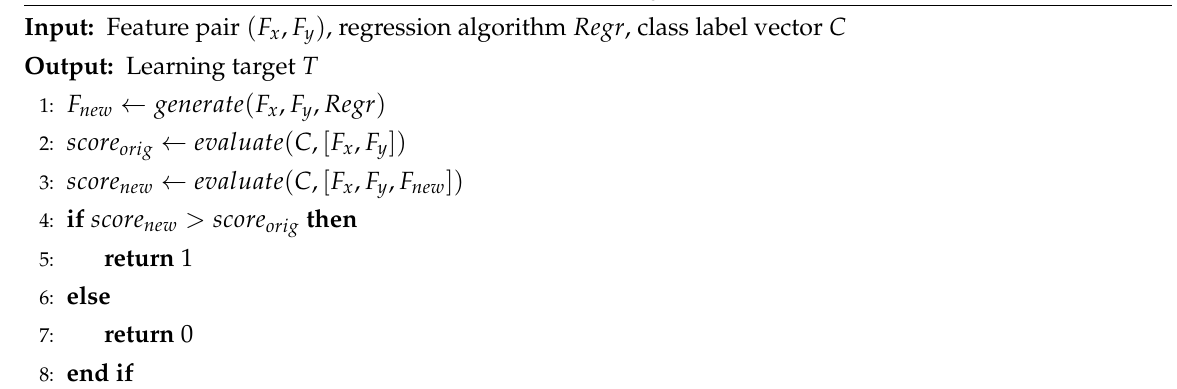
Algorithm 2 Target function for feature generation target gen